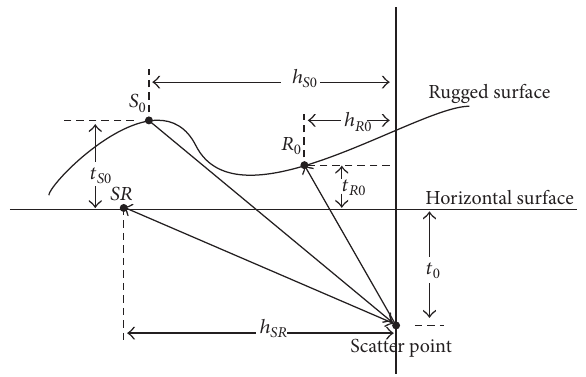
Figure 2: The sketch map to illustrate the equivalent offset for the rugged topography. 𝑆 0 is the source position, 𝑅 0 is the receiver position, and 𝑆𝑅 is the assumed collocated source/receiver position at the assumed horizontal surface.